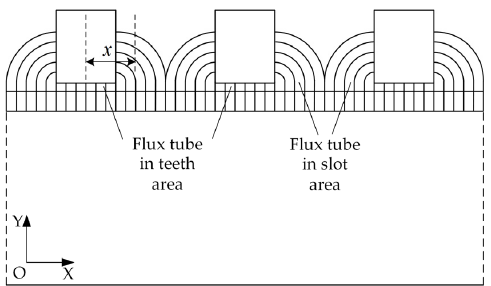
Figure 4. Equivalent quasi-flux tubes with boundaries determined by straight line and semicircular segments for permeance calculation.